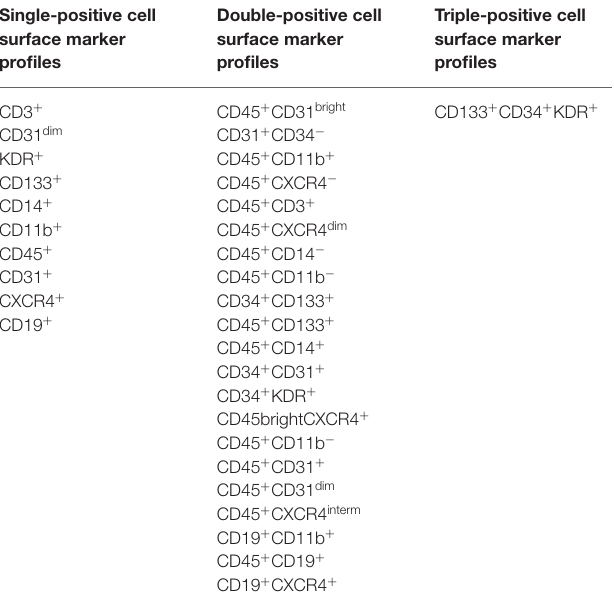
TABLE 1 | Cell surface marker expression used to report phenotypes of peripheral blood-derived mononuclear cells in the FOCUS-CCTRN trial (